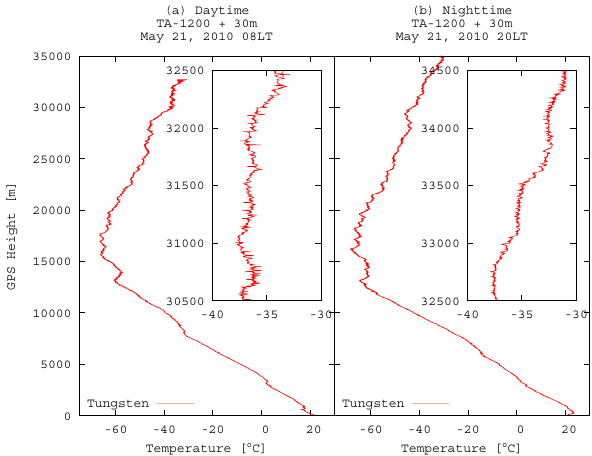
Fig. 8. The same as Fig. 3 but for those taken by the tungsten sondes after configuration change (see text for details). Observations are made at Moriya on 21 May 2010. The swing angle of the radiosonde with the suspension line of 30m in this case reaches 40 ◦ , which is larger than the solar zenith angle of about 25 ◦ for the daytime flight in (a) .